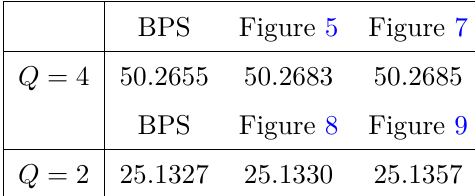
Table 1. Energies of BPS solutions (i.e. with (cid:15) = 0 ) compared with the theoretical BPS mass for given Q